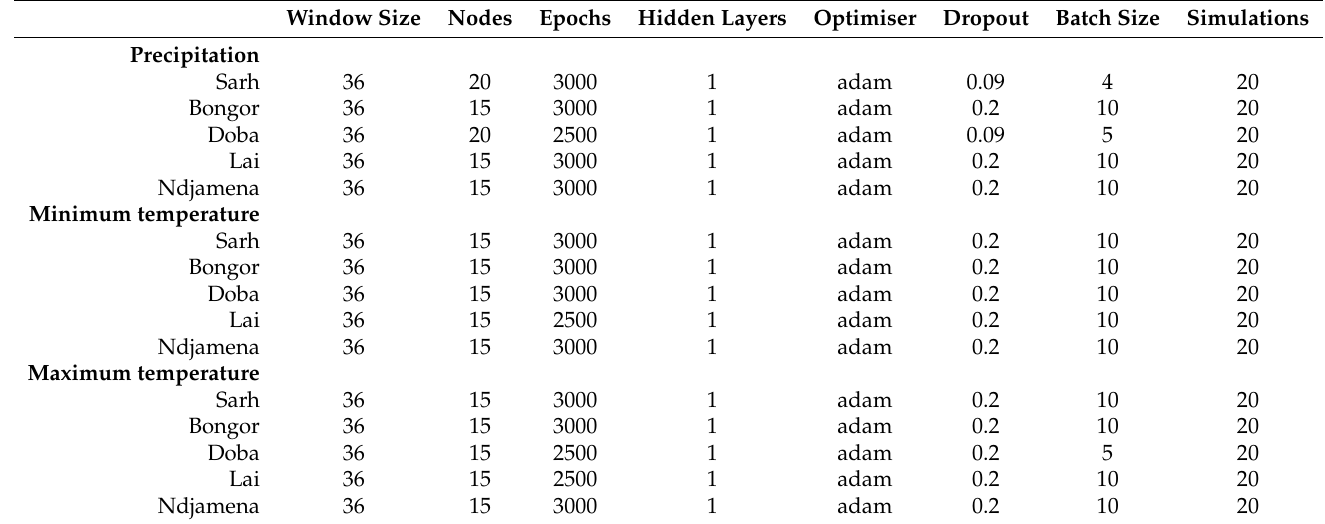
Table 4. The chosen LSTM architectures for precipitation, minimum and maximum temperature forecasting in the five gauging stations after hyperparameter